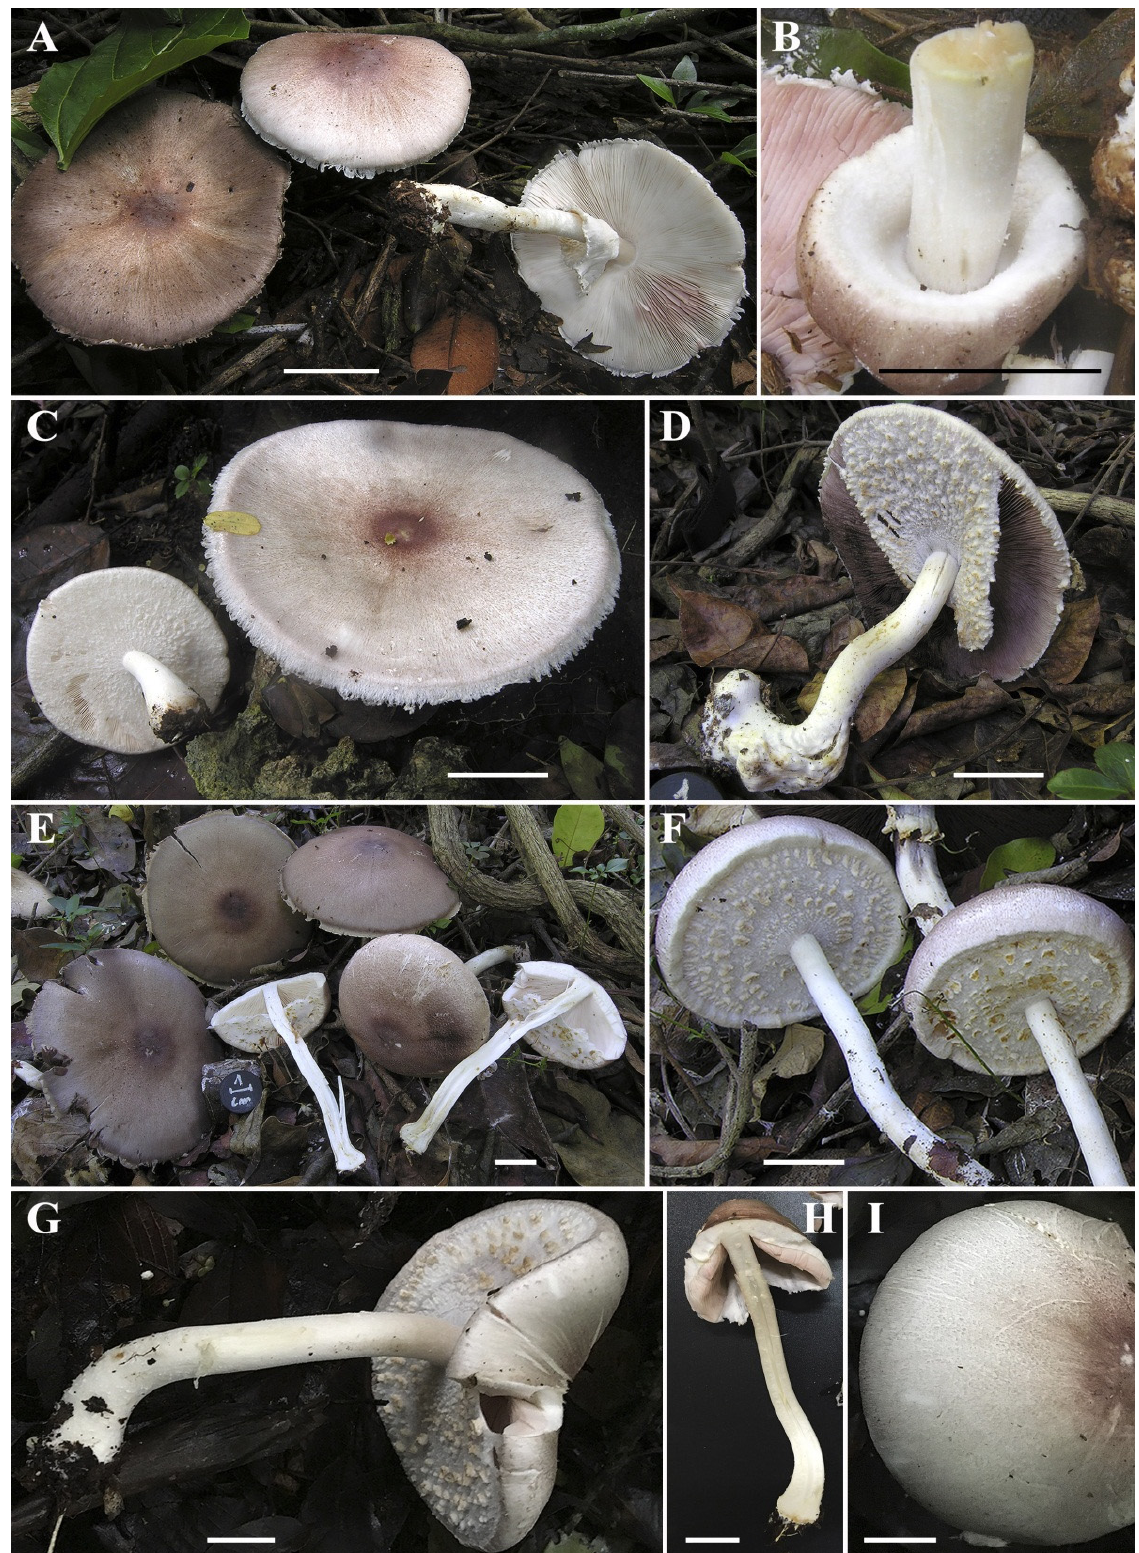
Figure 7. Macroscopic characters of Agaricus subrufescens . ( A – I ) Basidiomata. ( A ) LAPAM77; ( B , C ) LAPAM78; ( D ) LAPAM100; ( E , F ) LAPAM103; ( G – I ) LD201903. Bar = 2 cm. Photos by C. Angelini ( A – F ) and J. Chen ( G – I ).